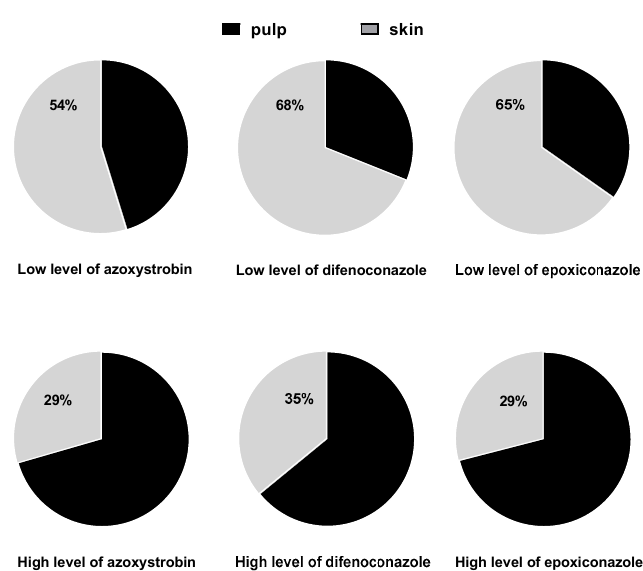
Figure 3. Distributions of the three pesticides in the peel and pulp of PRA treated with low and high pesticide concentrations (two and five times the recommended dosage, respectively).